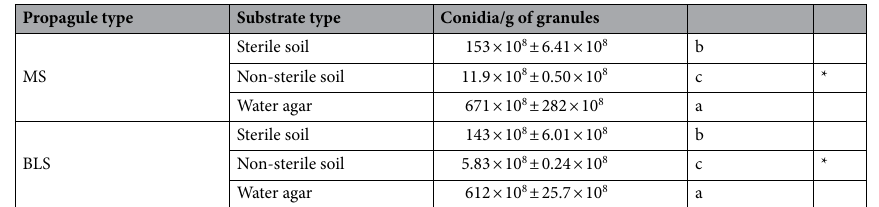
Table 1. Conidial yield (sporogenic germination) by granular formulations of microsclerotia (MS) or blastospores (BLS) of Metarhizium robertsii (IP 146 strain) on different types of substrates. Means (± SE) in the same column followed by different lowercase letters are significantly different among substrate types, and asterisk (*) indicates significant difference between MS and BLS within each substrate type. Pairwise multiple comparisons were conducted with the Tukey HSD test at P <